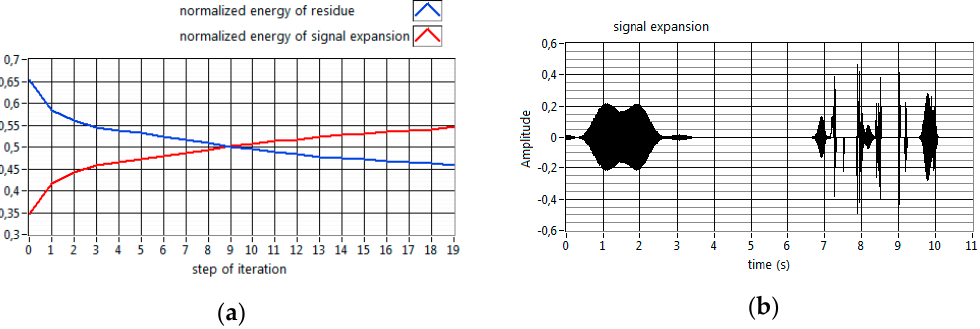
Figure 6. The plots: ( a ) the normalized energy of the residue and the normalized energy of the signal expansion as a function of the iteration steps in the MP algorithm; ( b ) the reconstructed measured signal for dictionary size equal to 20.